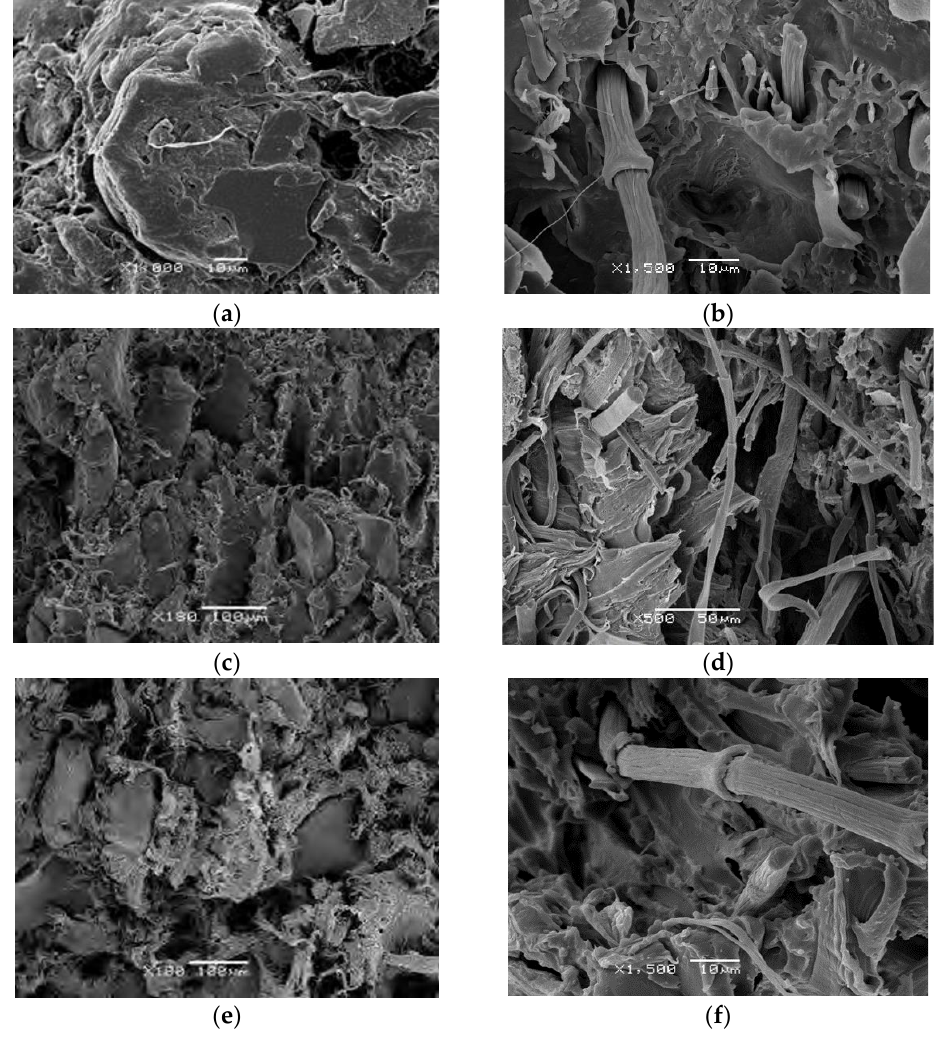
Figure 4. Scanning electron microscopy of the fracture surfaces of CFs and GTR based composites at composition of 40%: ( a ) HDPE/GTR, ( b ) HDPE/CFs, ( c ) PP/GTR, ( d ) PP/CFs, ( e ) EVA/GTR and ( f ) EVA/CFs.